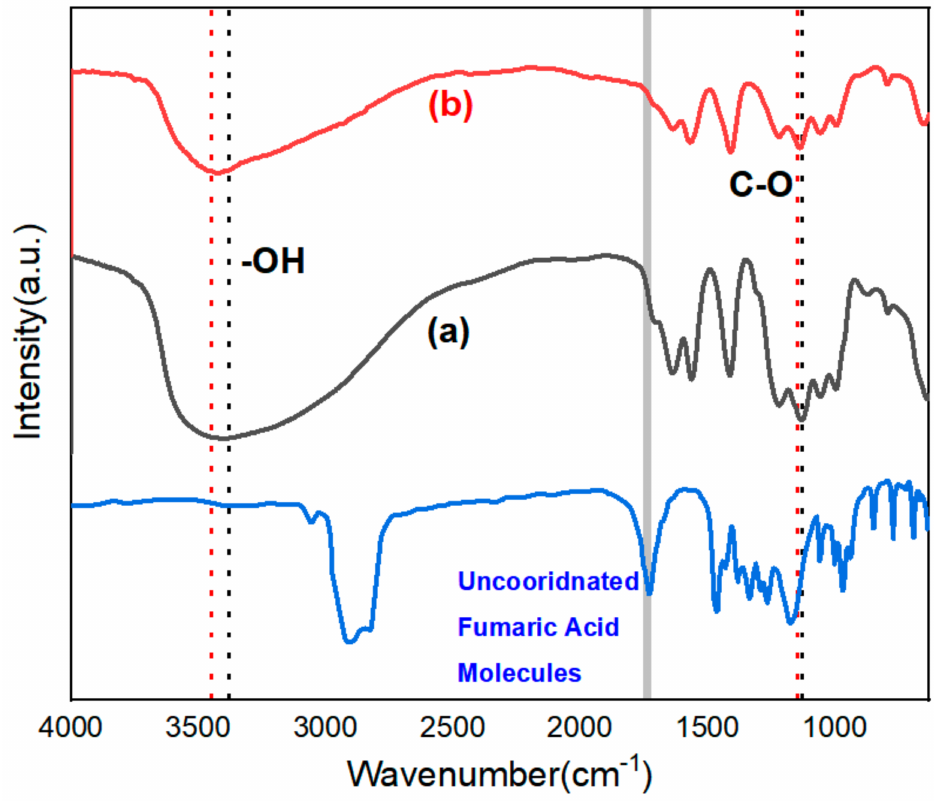
Figure 5. The infrared spectra of uncoordinated fumaric acid and MOF-801 formed in ( a ) 80 mL of ethanol, 20 mL of water, and ( b ) 20 mL of ethanol, 80 mL of water. Table 2. The absorption peaks of MOF-801 formed in (a) 80 mL of ethanol, 20 mL of water,